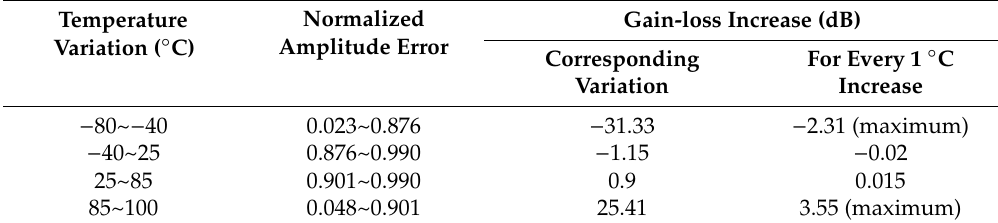
Table 1. Gain-loss under the effect of uniform temperature field.